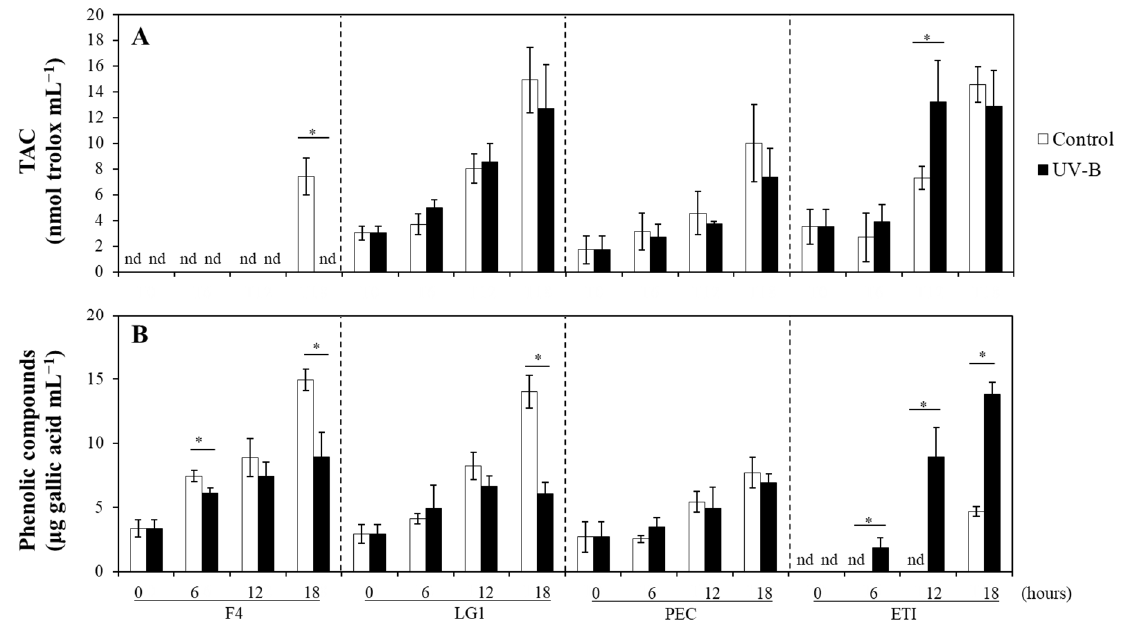
Figure 2. Effects of UV-B on the non-enzymatic antioxidants. ( A ) Total antioxidant capacity (TAC) and ( B ) phenolic compounds were determined in control (bars in white) and UV-B treated (bars in black) microalgal strains (F4, LG1, PEC, and ETI). UV-B exposure level was set at 1.7 W m − 2 supplemented with 70 μ mol m − 2 s − 1 photosynthetically active radiation (PAR) following a time course from 0 to 18 h. Control microalgal group only received PAR. Asterisks represent significant differences (* p < 0.05) between control and UV-B treatment within the same strain at a specific time point. Data are expressed as means of 3 different replicates ± standard deviation (SD). nd: not detectable. F4 and LG1: Chlorella sorokiniana strains; PEC: Pectinodesmus pectinatus strain; ETI: Ettlia pseudoalveolaris strain.